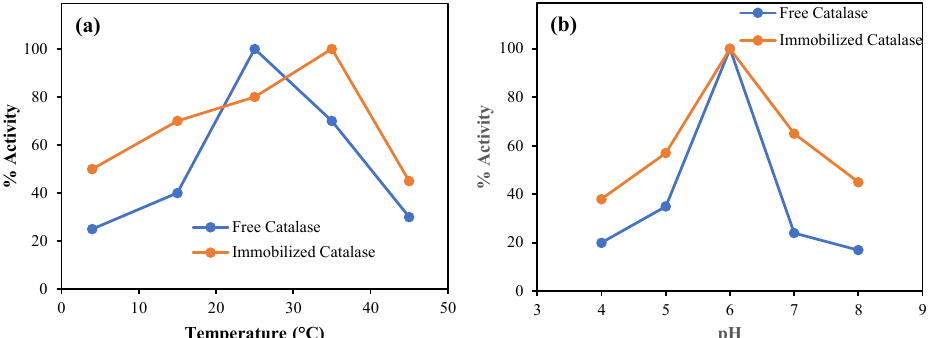
Figure 7. ( a ) Effects of temperature on % activity of free catalase and immobilized catalase enzymes onto p(HEMA-co-AGE) cryogels [reaction conditions: 50 mM phosphate buffer, pH 6.0], and ( b ) effects of pH on % activity of free and immobilized catalase enzymes onto p(HEMA-co-AGE) cryogels [reaction conditions: 50 mM phosphate buffer, T = 35 °C].